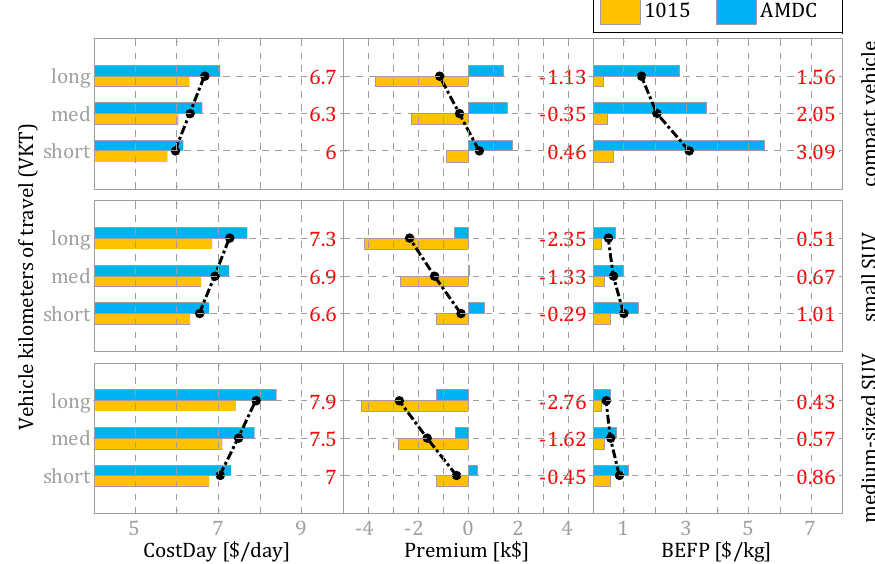
Figure 8. Cost per day ( first column ), cost premium ( second column ) and break-even fuel price ( third column ) for the compact vehicle ( first row ), small SUV ( second row ) and medium-sized SUV ( third row ), over the 1015 (yellow) and AMDC (cyan) missions for different VKT s.